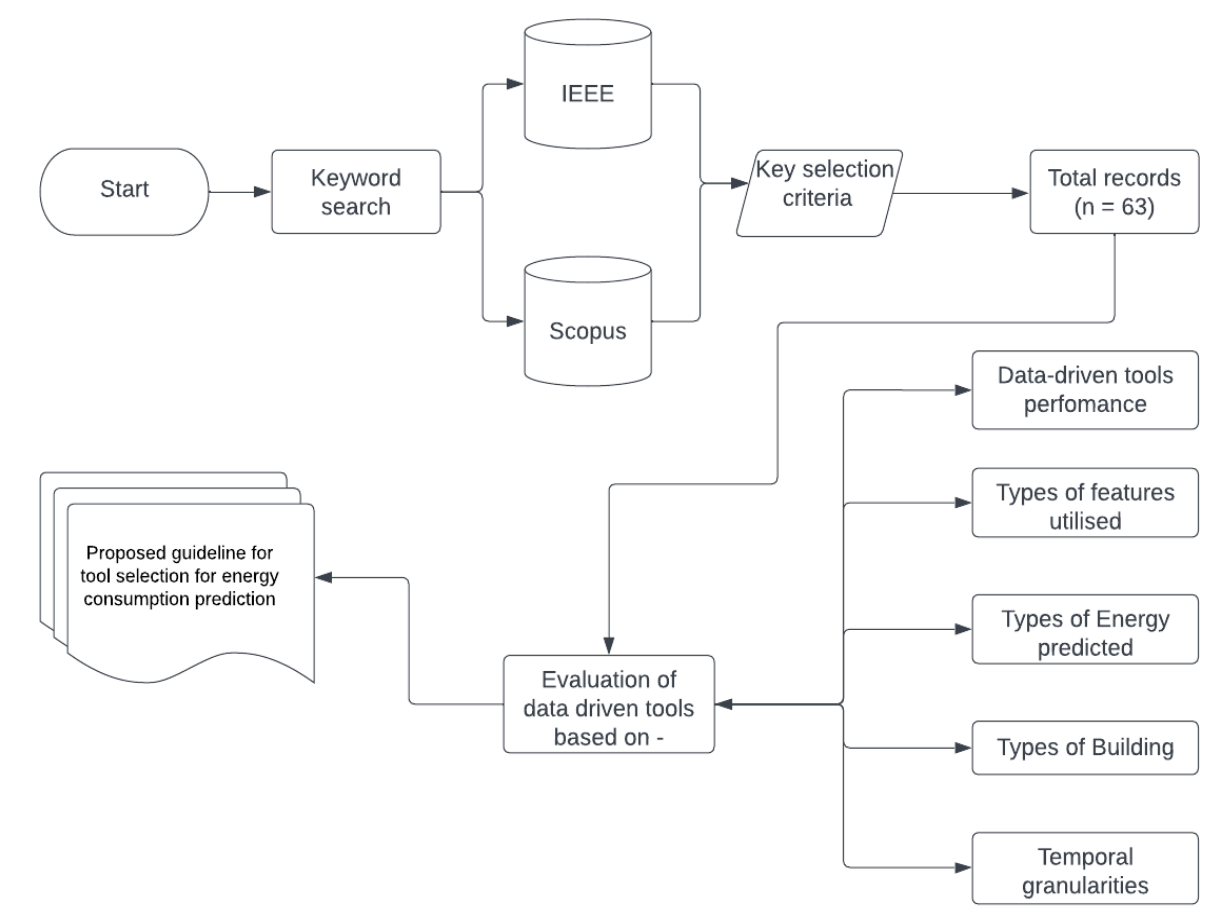
Figure 1. Diagram of the review framework.